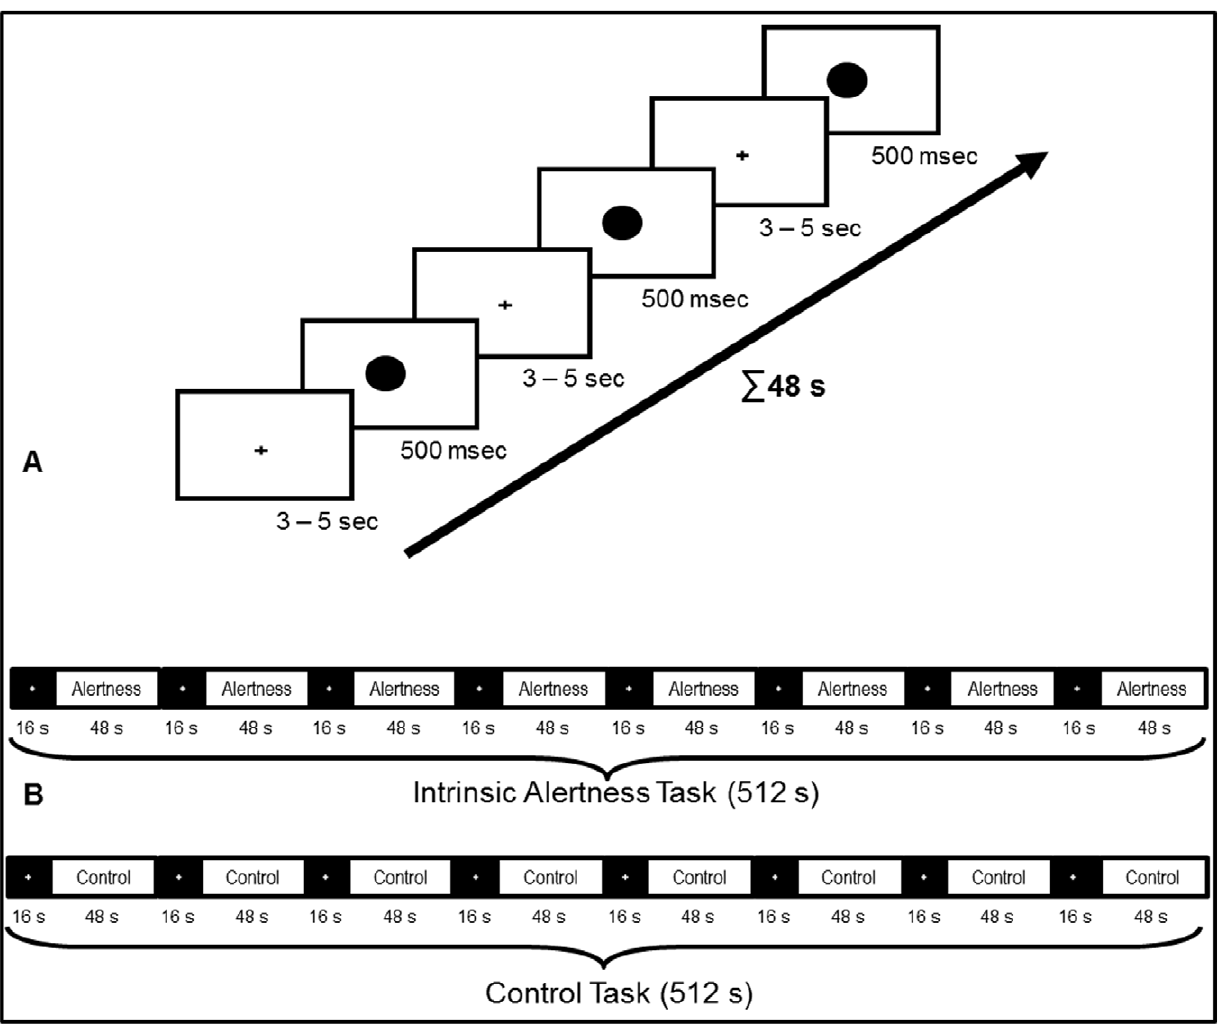
Figure 1. Complete overview of the experimental setup. ( A ) shows the timing of 3 trials for the intrinsic alertness task. During each trial, participants were instructed to fixate the cross at the center of the screen and wait for the target stimulus, which was a black circle presented at the center of the screen. The inter-stimulus interval was always randomized between 3 and 5 s, and the target stimulus was presented for a maximum duration of 500 ms. This intrinsic alertness task was presented in blocks of 48 s, with a maximum of 14 trials in one block. ( B ) shows the overall timing for both the intrinsic alertness task and the control task, during the whole experimental run. Both tasks were presented in separate experimental runs, and the order was randomized across all participants. Both experimental runs always started with the low-level baseline condition (resting period, 16 s), followed by an experimental block (48 s). Within one experimental run, 8 experimental blocks were alternated with 8 resting periods, resulting in a total duration of 8 minutes and 32